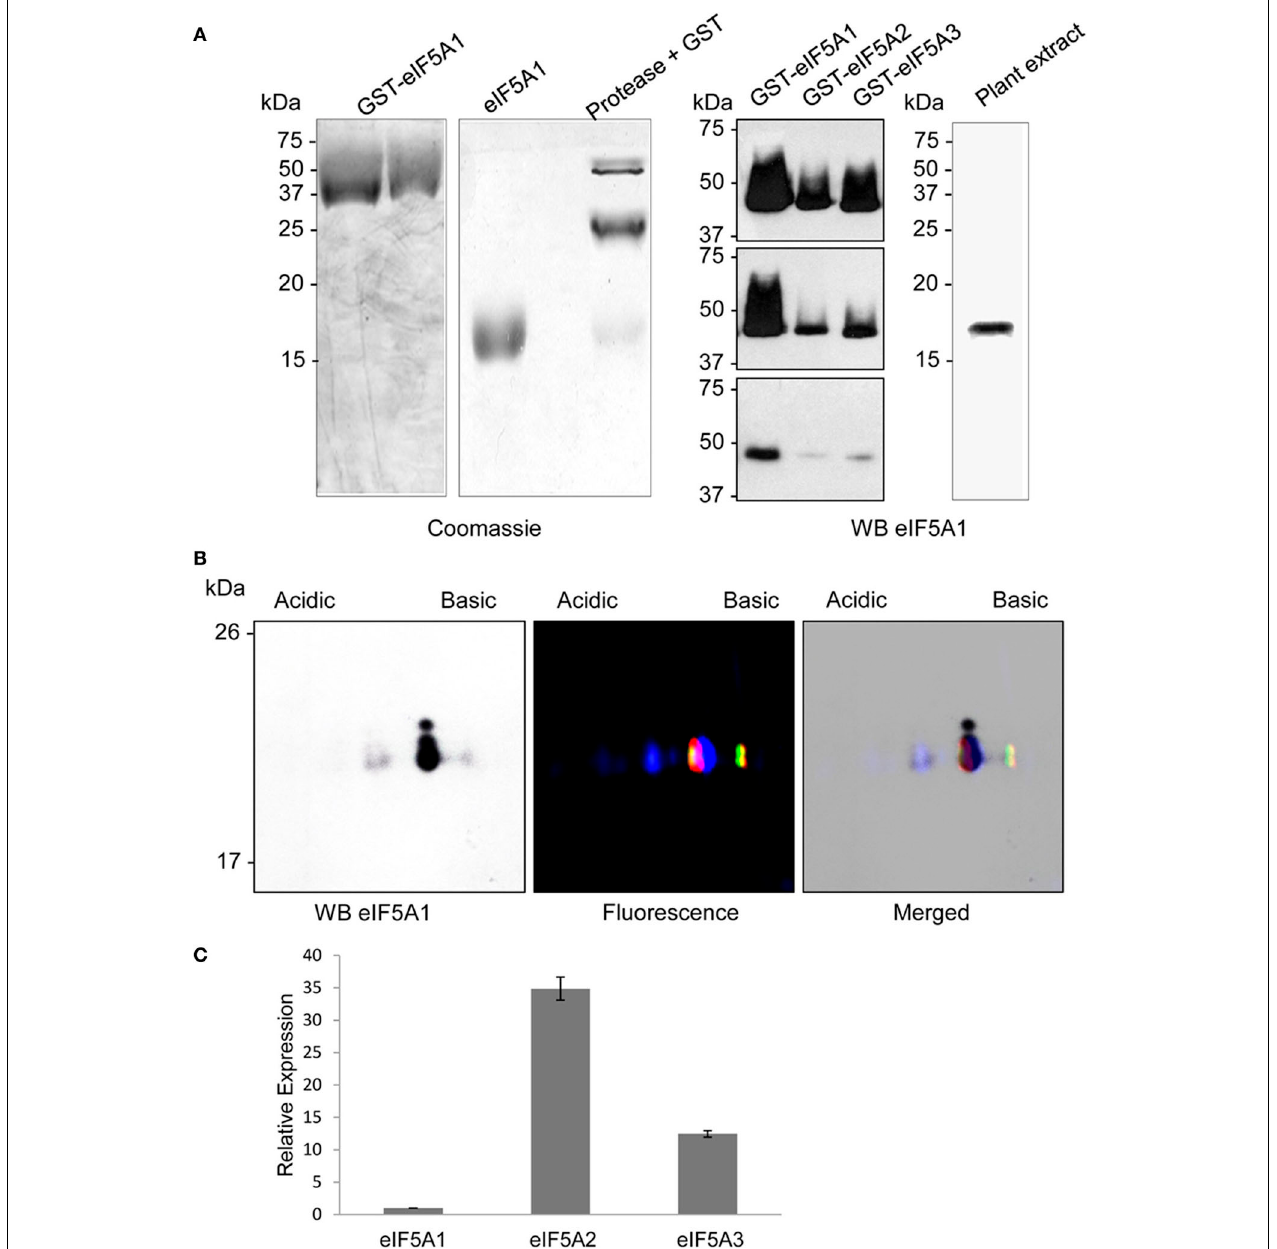
FIGURE 5 | Antibody production and immunological detection of eIF5A proteins. Recombinant unmodified GST-eIF5A1protein was purified by glutathione sepharose affinity chromatography and cleaved with Protease 3C to yield highly pure eIF5A1 protein (coomassie stained gels on A ). The polyclonal antibody generated against eIF5A1 protein was used to check cross-reactivity to recombinant GST-eIF5A proteins (1 μ g, 500ng, and 50ng in the upper, medium, and lower panel, respectively) and immunological detection on total plant protein extract by western